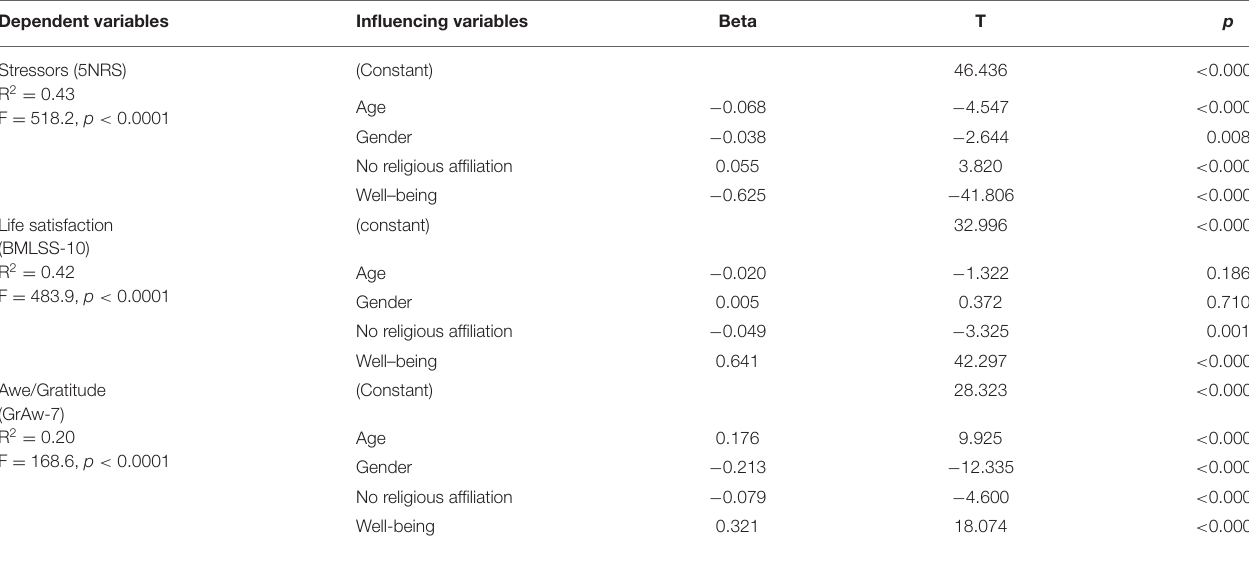
TABLE 6 | Regression analyses with constant influencing variables age, gender, lack of religious affiliation, and well-being. Dependent